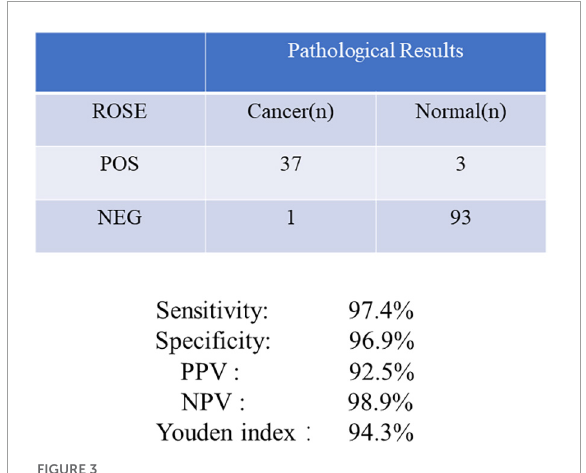
FIGURE3 Comparison of the ROSE diagnosis during EBUS-TBNA with the final pathological findings.